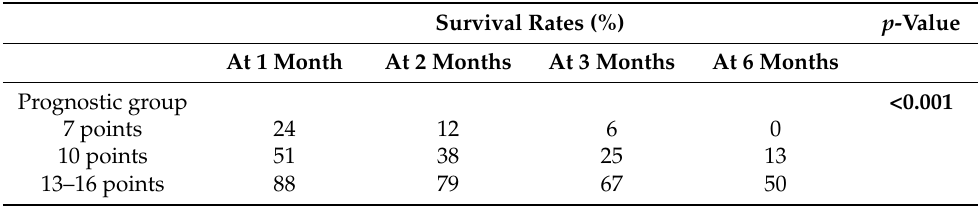
Table 4. Three prognostic groups and corresponding survival rates at 1, 2, 3, and 6 months. Survival Rates (%)